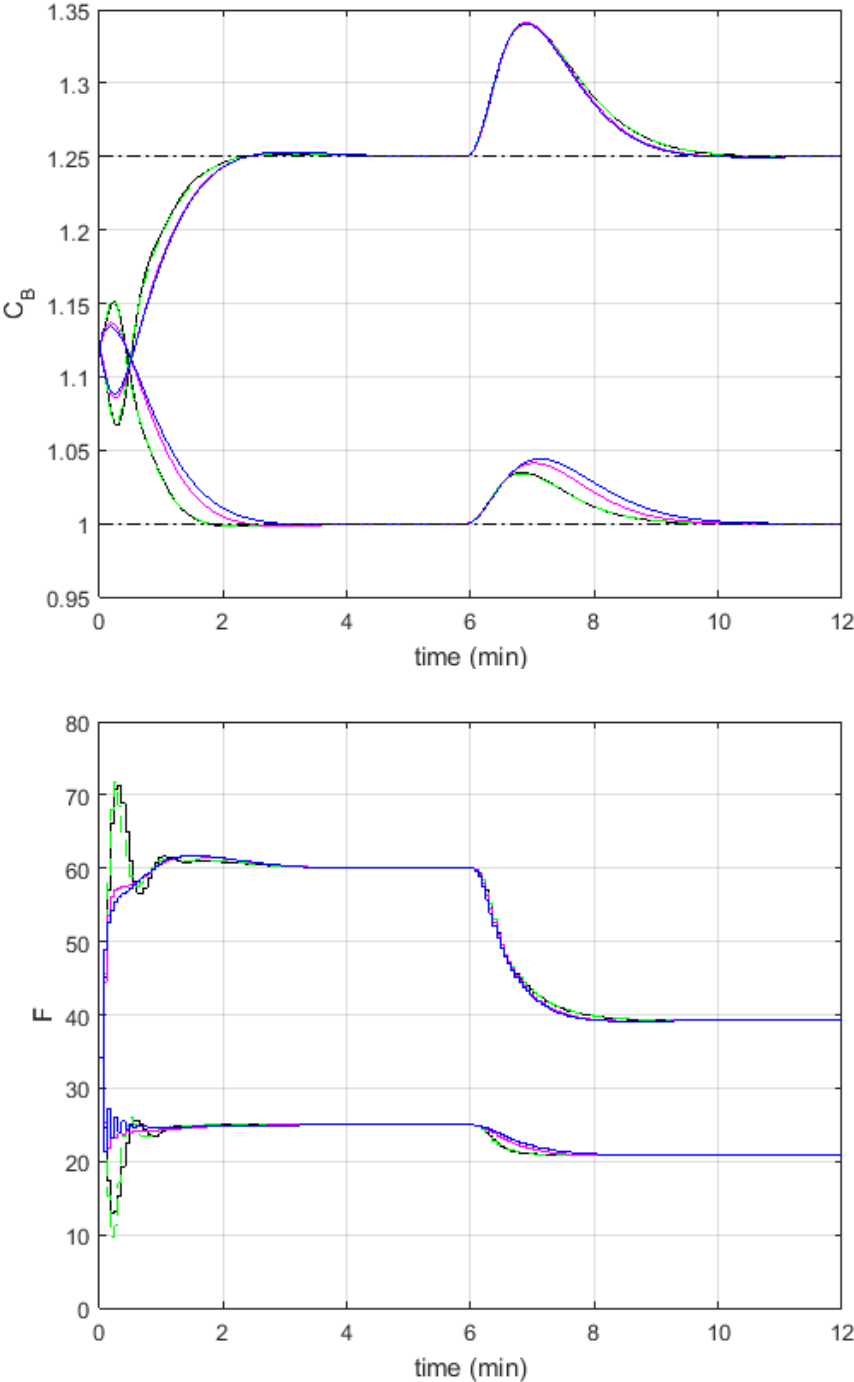
Figure 6. Responses of the control system with FMPC2 algorithm and λ = 0.001 to changes in the setpoint to C B 1 = 1 mol/L and C B 2 = 1.25 mol/L and to the change of the disturbance by 10% in the 6th minute of the experiment; s = 35—black lines, s = 5—green dashed lines, s = 2—magenta lines, s = 1—blue